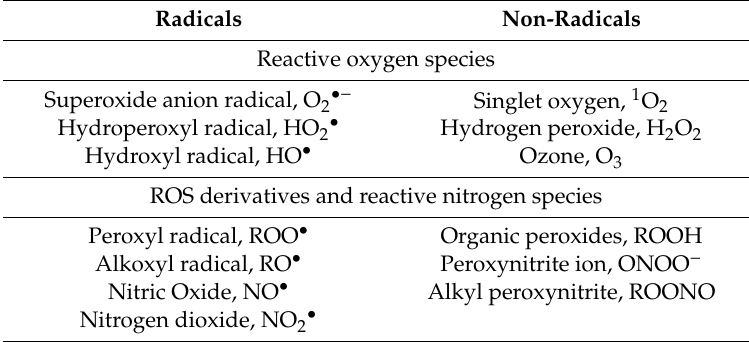
Table 1. Most significant reactive oxygen species (ROS) and ROS derivatives. R is a residual of an organic